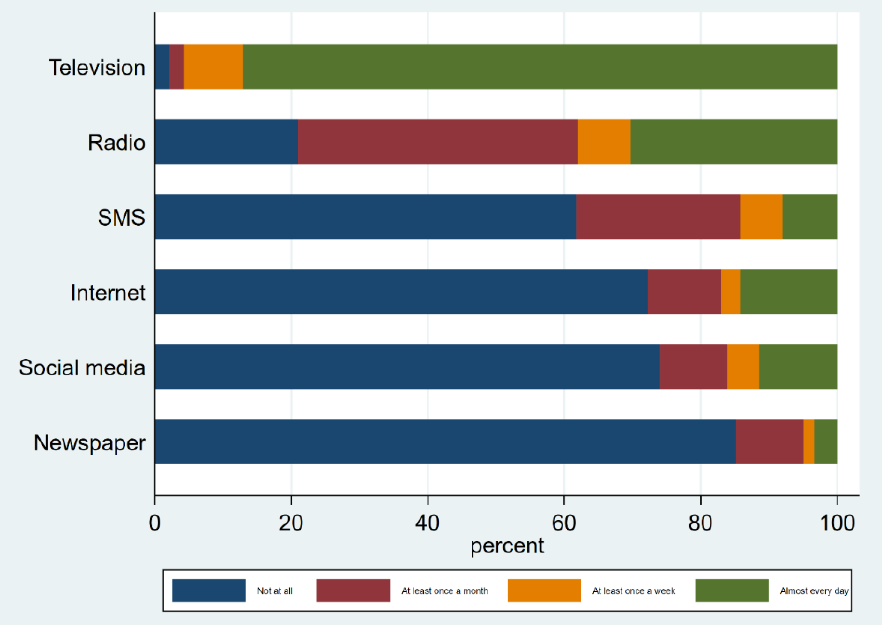
Table 1. Socio-demographics for the study population.